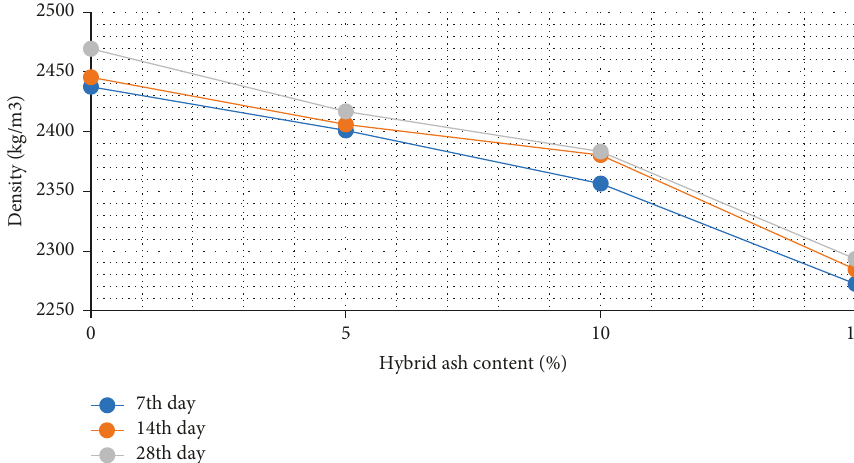
Figure 8: Density reduction with respect hybrid ash